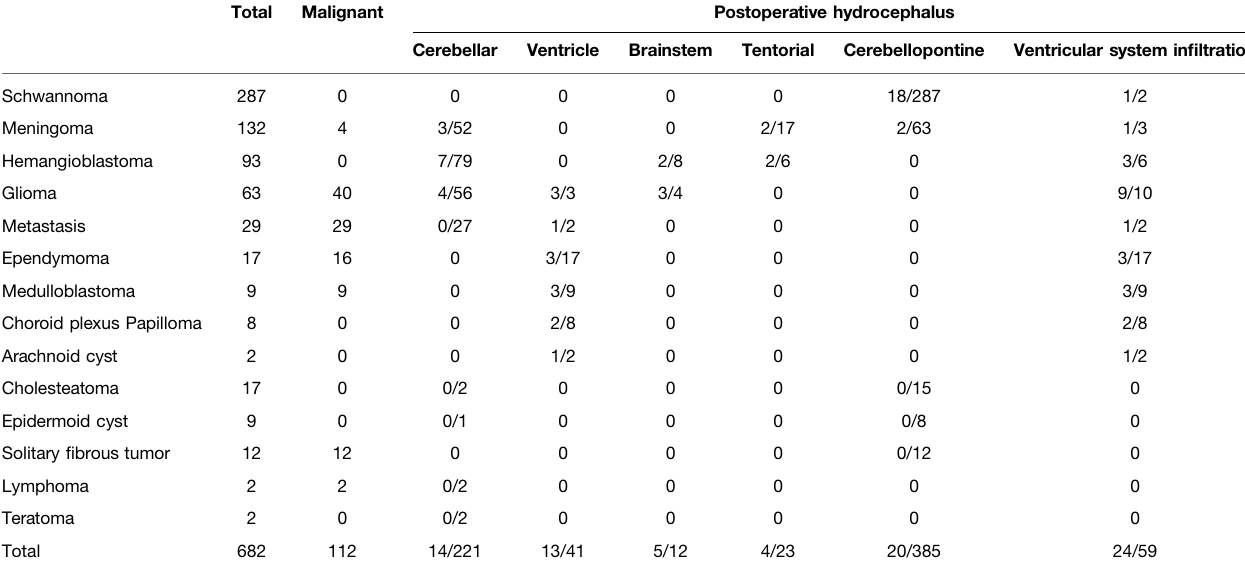
TABLE 2 | Demographic and clinical characteristics of patients with PFTs.